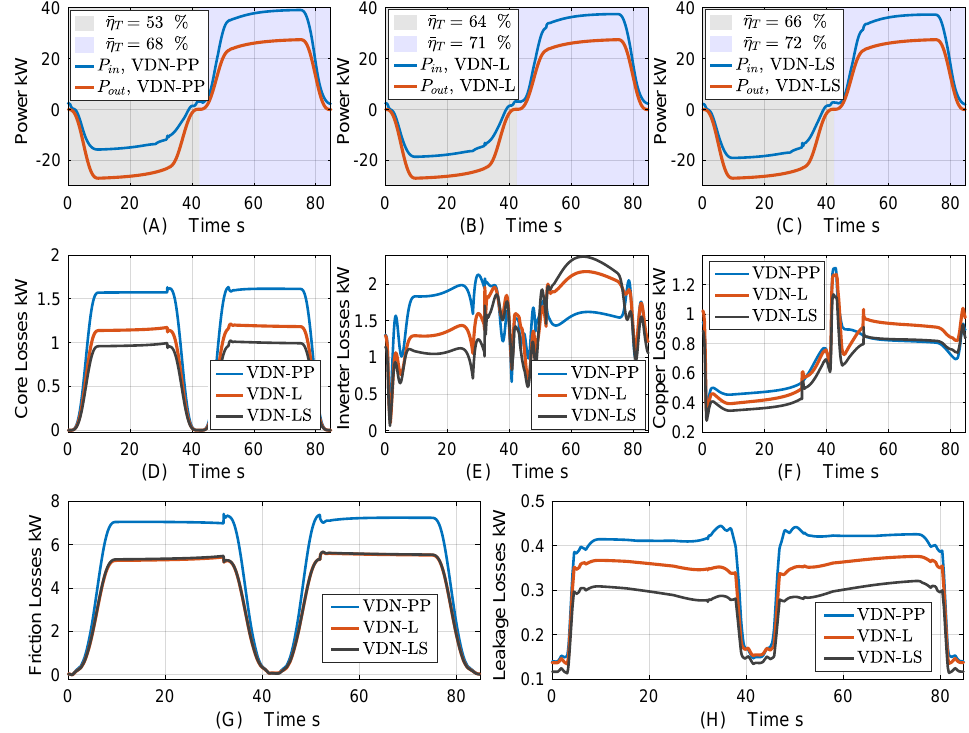
Figure 22. ( A ) Input and output power of VDN with point-to-point topology; ( B ) input and output power of VDN with linear topology; ( C ) input and output power of VDN with linear topology with shared chambers; ( D ) VDN core losses; ( E ) VDN inverter losses; ( F ) VDN copper losses; ( G ) VDN friction losses; ( H ) VDN leakage